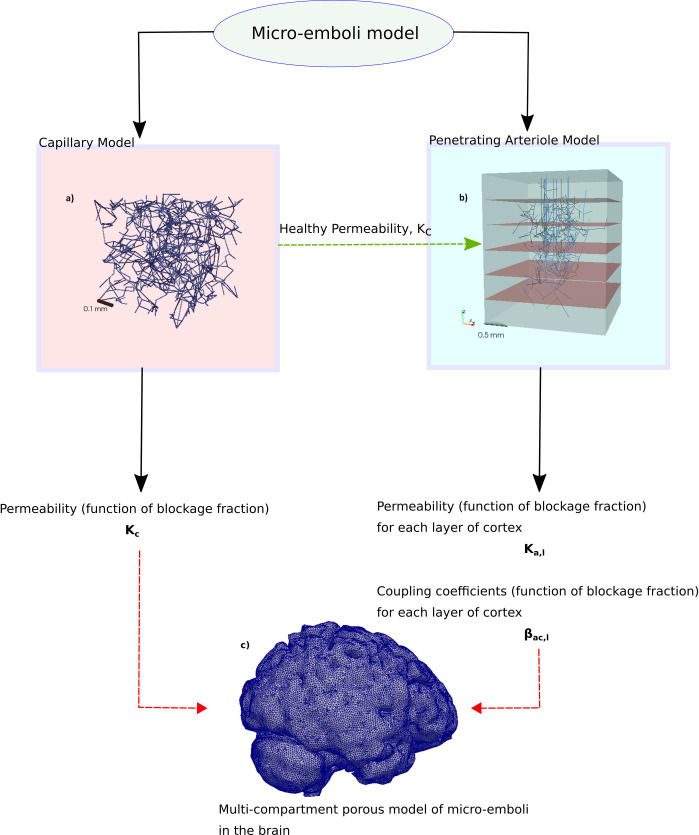
A schematic representation of the overarching model simulating micro-emboli in the brain post-thrombectomy. Two separate models are developed in this paper: a) a micro-emboli model of the capillary bed (based on geometrically representative networks) and, b) a micro-emboli model of the penetrating arterioles. The grey region in b) represents the homogenized healthy capillary bed to which the terminal vessels of the trees couple. The red planes denote the dividing planes between the 6 layers of the voxel over which the blood flow characteristics will be calculated. c) Is a porous multi-compartment representation of the brain which will depend on the parameters derived from the models in a) and b). The full brain is not simulated in this paper.